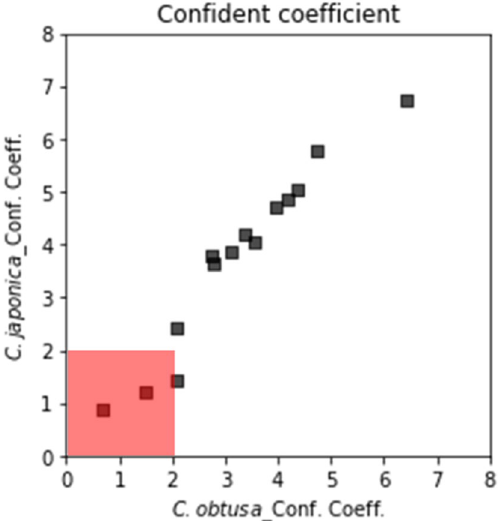
Figure 6. Results of confidence coefficients. If a confidence coefficient is in the red shaded area (> 2.0), the calculation result from the Automated Multi-taxa Pollen Counting Estimation System (AME) system was regarded as